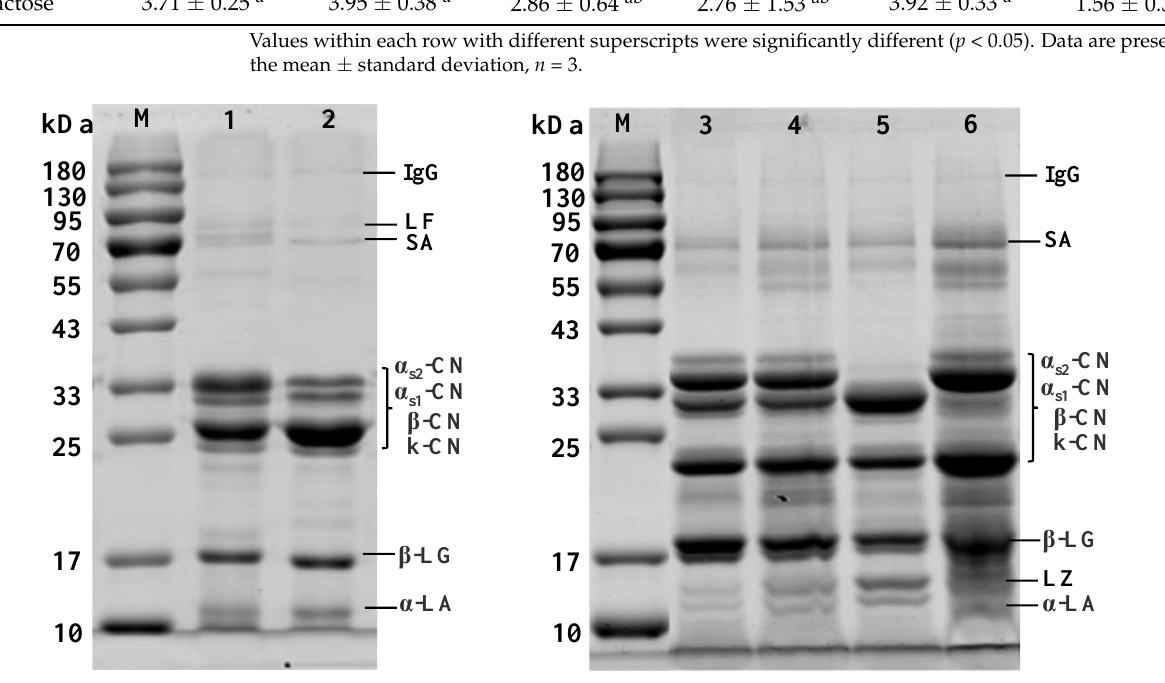
Figure 1. SDS-PAGE analysis of canine, bovine, and caprine milk. Lanes: M: Prestained protein molecular weight marker, (1) Holstein, (2) Saanen, (3) Golden Retriever, (4) Labrador, (5) Caucasian Sheepdog, (6) Rottweiler. LF: Lactoferrin, SA: Serum albumin, β -LG: β -lactoglobulin, LZ: Lysozyme, α -LA: α -lactalbumin, IgG: Immunoglobulin G, α s1 -CN: α s1 -casein, α s2 -CN: α s2 -casein, β -CN: β -casein, κ -CN: κ -casein.